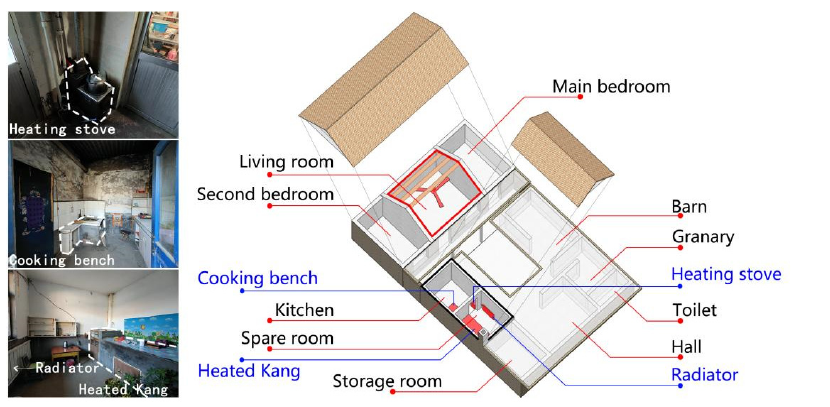
Figure 9. Traditional cooling and heating system arrangement.